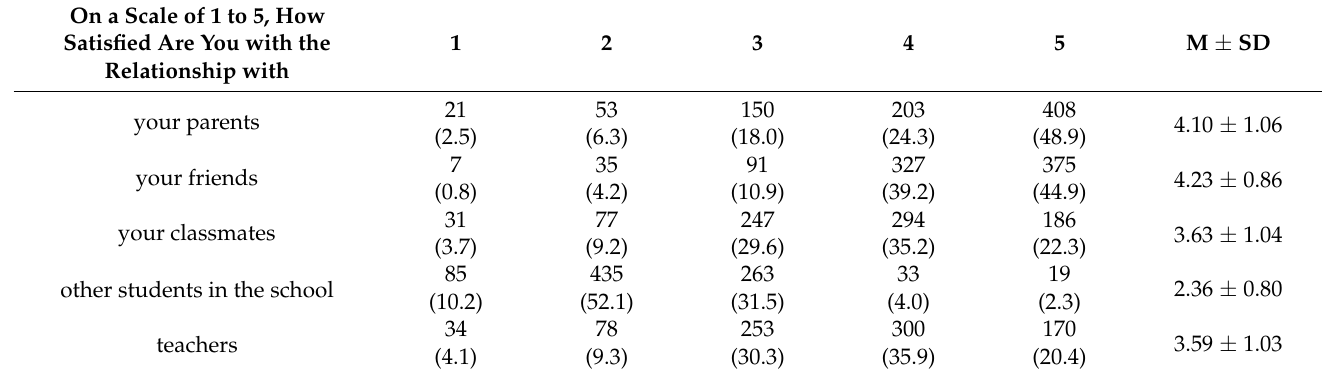
Table 2. Self-rated items regarding satisfaction with relationship with different categories of people 1